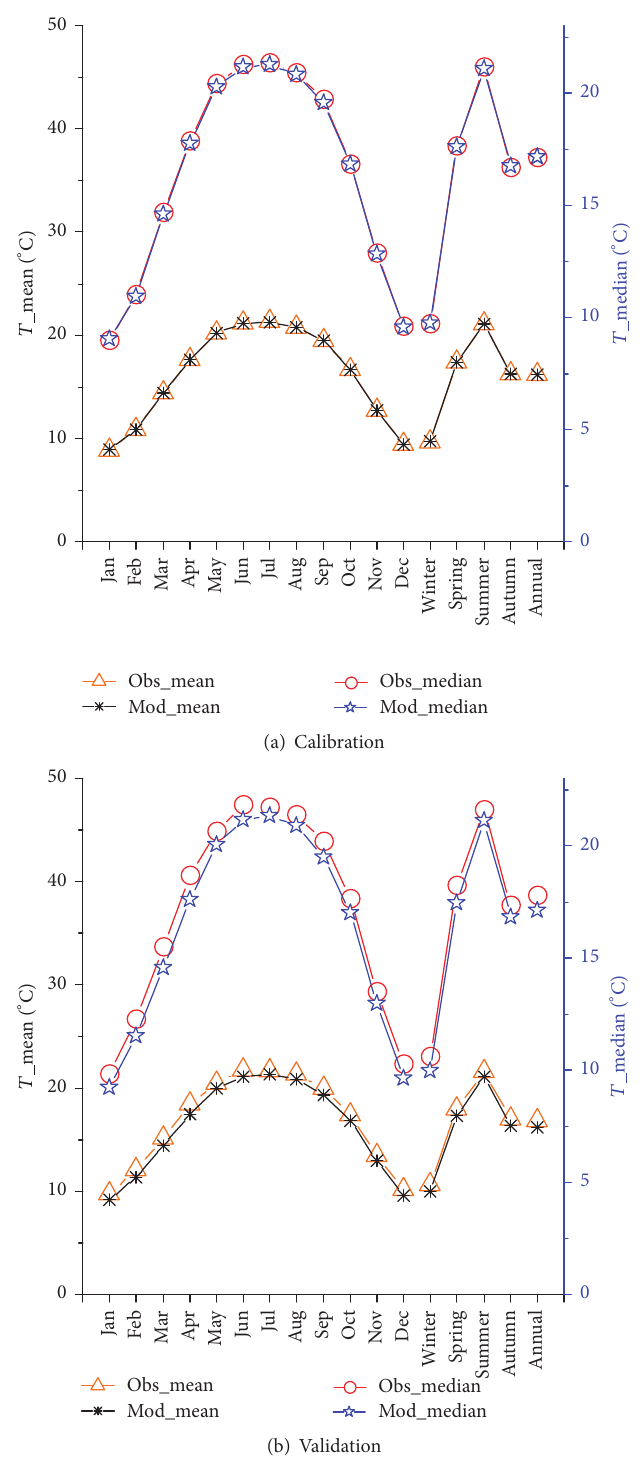
Figure 2: Modeled and observed mean values of air temperature during calibration and validation